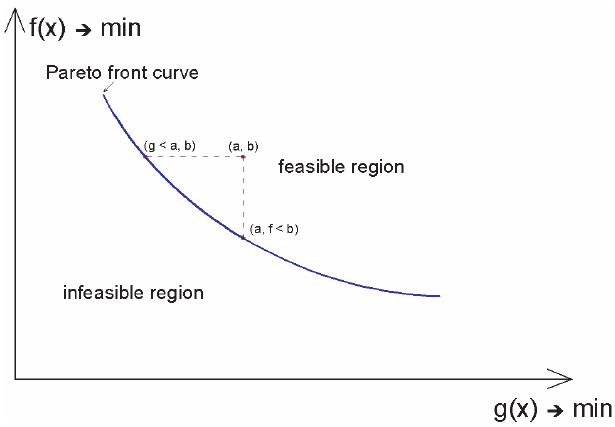
Fig. 1. Typical Pareto front